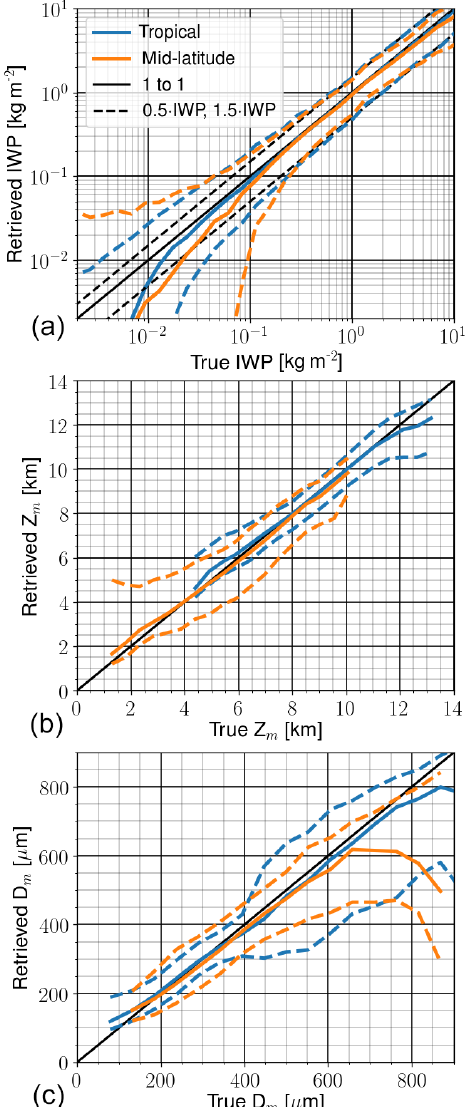
Figure 9. Estimated retrieval performance for IWP (a) , Z m (Eq. 4, b ) and D m (Eq. 5, c ). Tropical refers to data at latitudes between 30 ◦ S and 30 ◦ N, while mid-latitude includes data for November to January between 35 and 65 ◦ N. The blue and yellow solid lines show the median of retrieved median value, while the corresponding dashed lines show the median of retrieved 5th and 95th percentile. The performance for Z m and D m is shown for states with an IWP above 25 and 50gm − 2 for tropical and middle latitudes, respec-